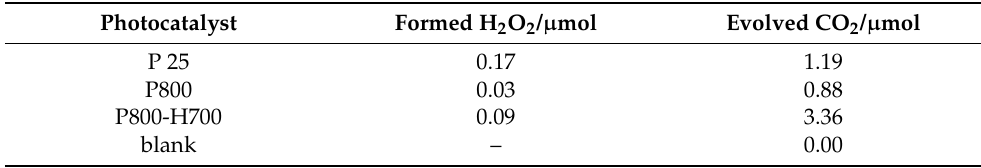
Table 1. Photocatalytic reaction in 1 vol% CH 3 COOH aqueous solution after violet light irradiation for 20